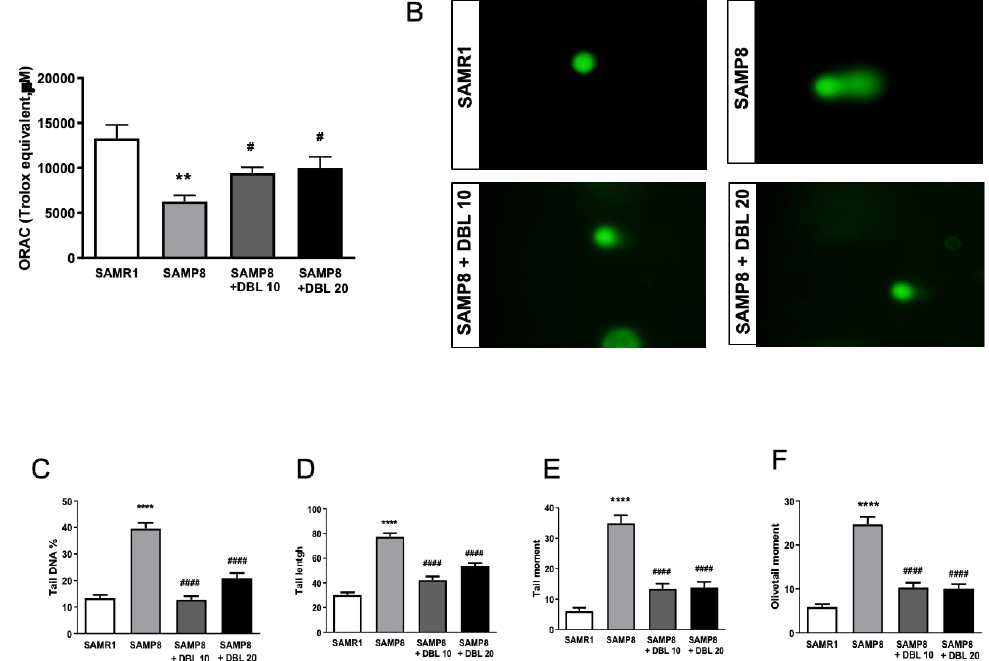
Figure 1. ( A ) The antioxidant capacity of 3,4-dihydroxybenzalacetone (DBL) as measured by an oxygen radical antioxidant capacity (ORAC) assay. The reduction of aging-induced oxidative DNA damage after DBL treatment ( B – F ): B . The representative photomicrographs of typical comet figures stained with SYBR Green-II. The DNA damage was detected by a single-cell gel electrophoresis assay (comet assay) in cardiomyocytes of all groups at 200× magnification. The quantification of DNA damage analyzed by digital imaging casp-software. The tail DNA percentage, D . The tail length, E . The tail moment, and F . the Olive tail moment. The data represent the mean ± standard error of the mean (SEM). ** p < 0.01, **** p < 0.0001 vs. the group of senescence-resistant control (SAMR1) mice; # p < 0.05, #### p < 0.0001 vs. senescence-accelerated mouse-prone 8 (SAMP8) mice, using a one-way